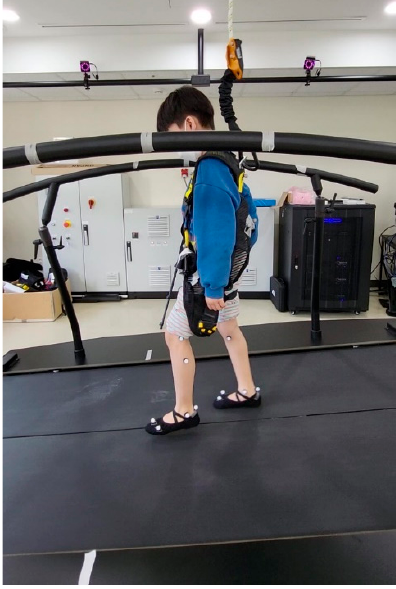
Figure 1. Gait analysis on a dynamic pitch treadmill using a computerized three-dimensional motion capture system. Twenty-six reflective markers were attached to the lower limbs according to the Human Body Model. The participants walked 20 strides for each ramp on both uphill and downhill trials. They were observed prior to inclination change and wore the harness for safety during the study.